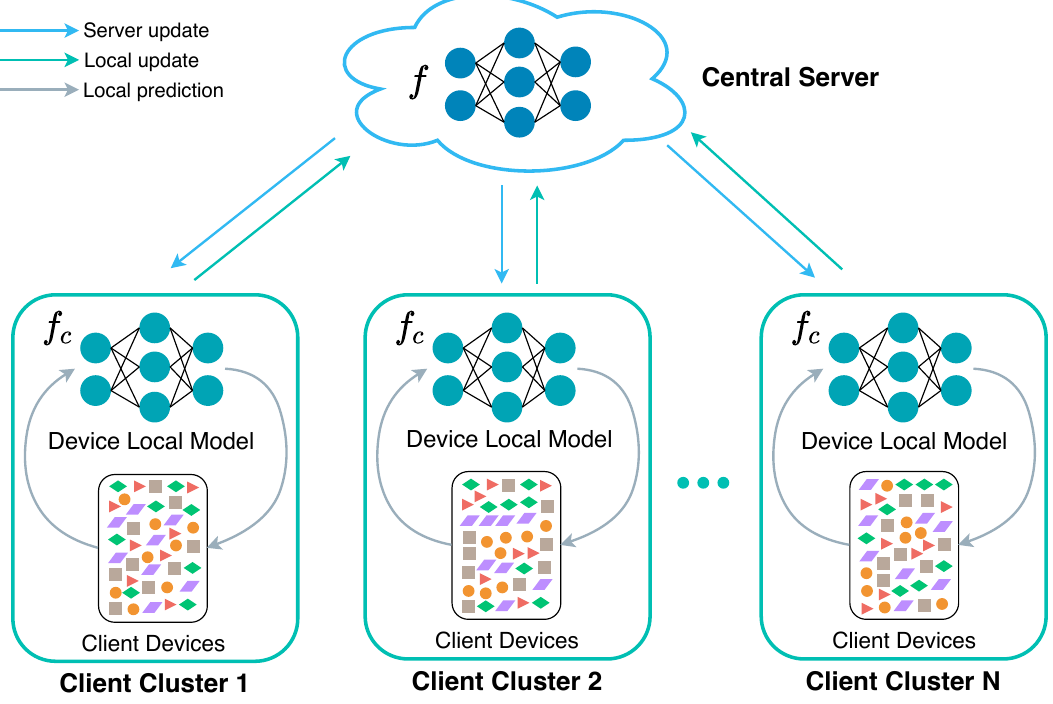
Figure 2. Illustration of the motivations. The client clusters represent companies where each cluster contains many heterogeneous devices as Federated Learning clients. The local model of a device participates in FL training and task inference